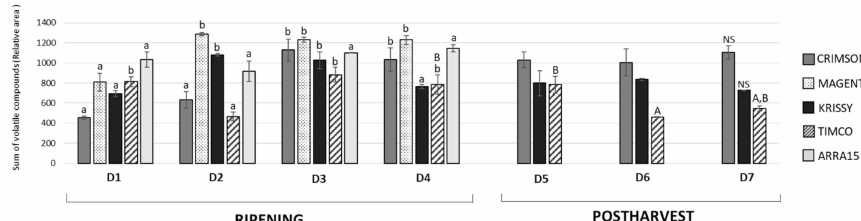
Figure 3. Evolution of the total volatile amounts during ripening and storage of the grapes (expressed in relative area). Values in the bars with di ff erent superscript letters indicate statistically significant di ff erences ( p < 0.05). Lower case (a): ANOVA test applied among ripening samples (D1–D4); Upper case (A): ANOVA test applied among harvest and storage samples (D4–D7). ns: nonsignificant di ff erences found. Sampling along harvest: D1 , veraison; D2 , 12 DAV (days after veraison); D3 , 26 DAV; D4 , 37 DAV. Sampling along storage: D5 , 54 DOS (days of storage); D6 , 75 DOS; D7 , 108